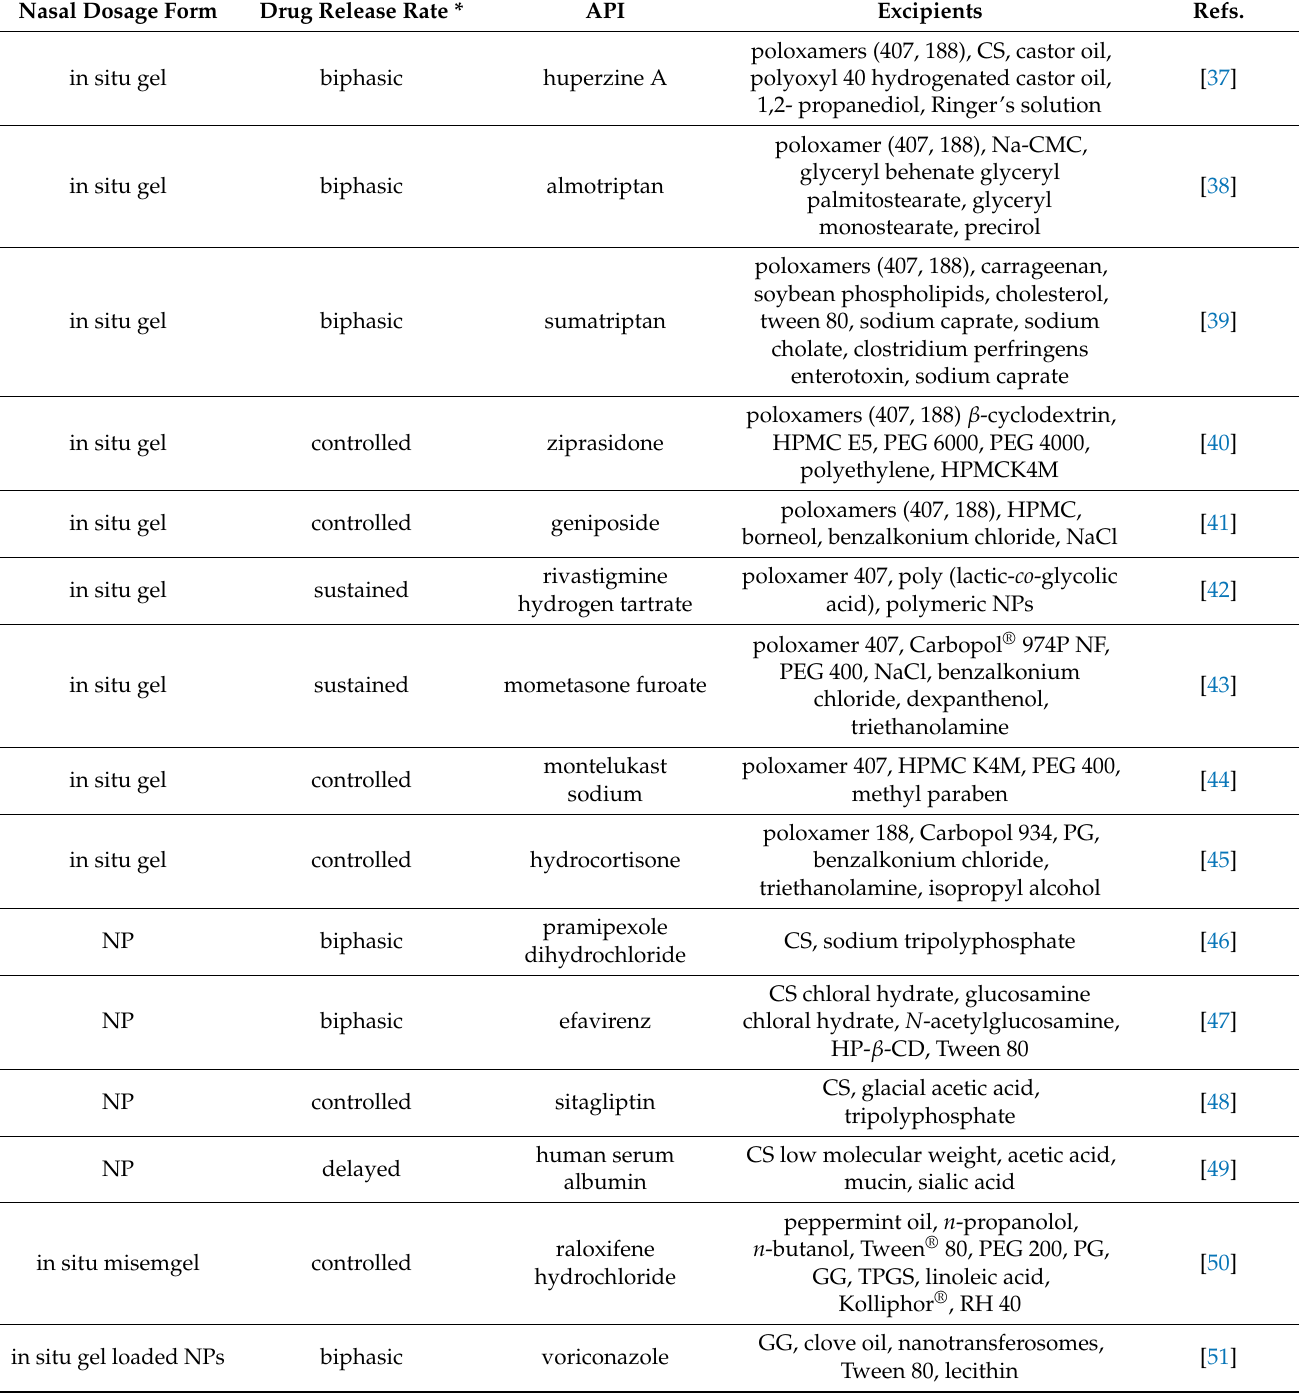
Table 2. Semi-solid formulations for modified release nasal drug